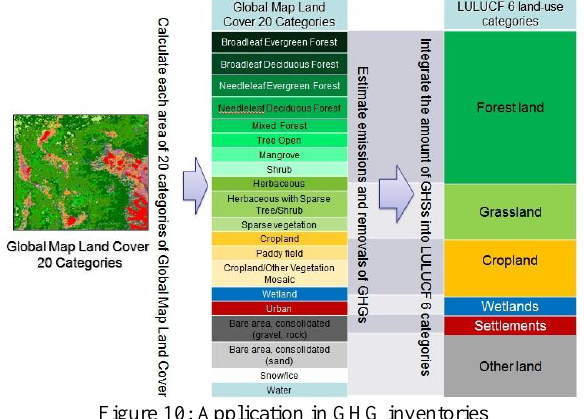
Figure 10: Application in GHG inventories Application in the field of Biodiversity Protection: By overlaying the Global Map on data of wild life habitats, it is possible to visualize the spatial distribution of biodiversity, providing supports in biodiversity conservation.